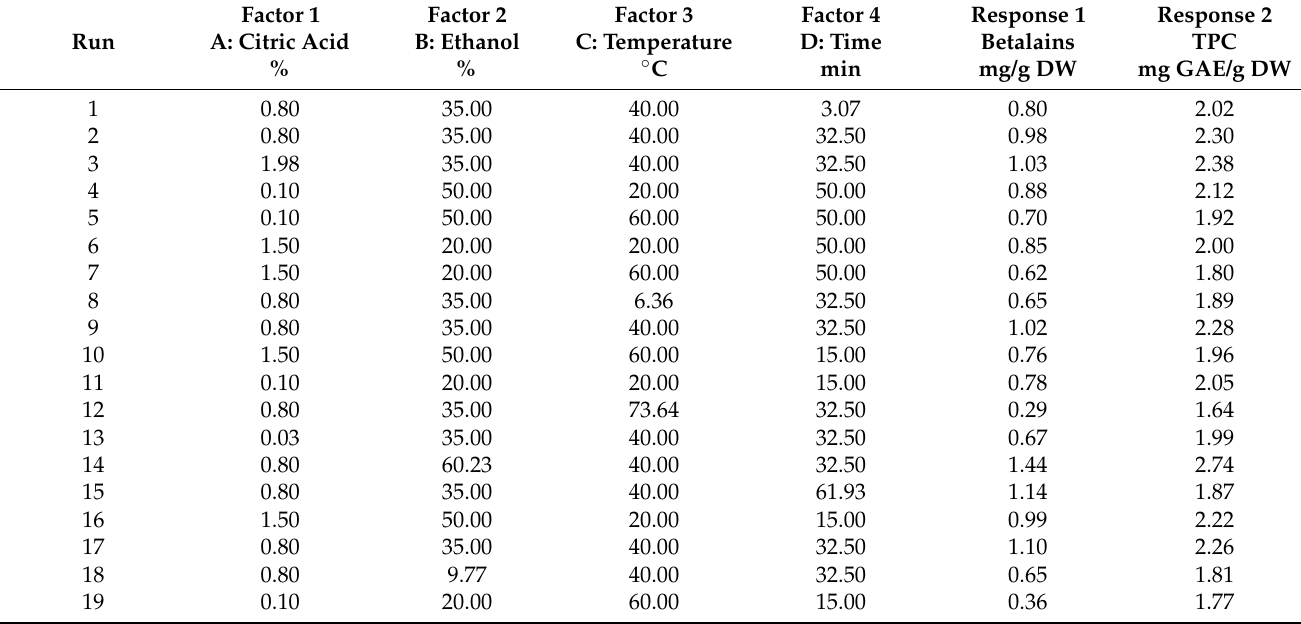
Table 2. The CCD matrix with the actual values of the main variables